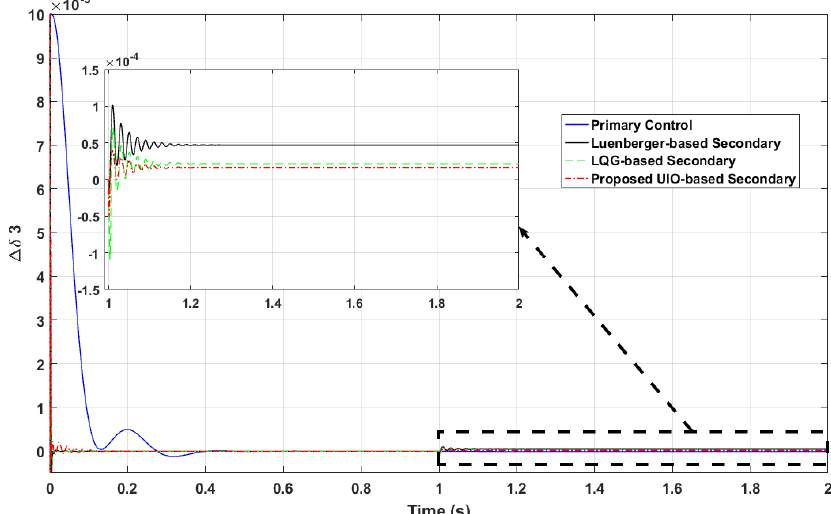
Figure 7. Third inverter angle δ 3 in scenario 1 (Step load